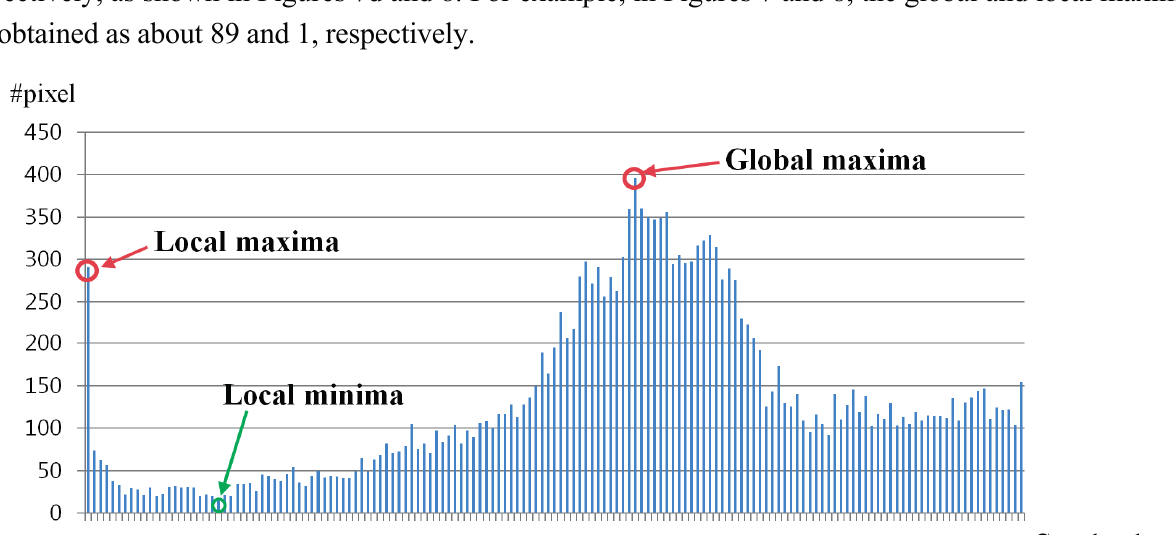
Figure 8. Detecting the position of local minima between the positions of global and local maxima. Between the positions of the global and local maxima, the position of local minima (whose number of pixels is the smallest) can be detected, which represents the boundary between the iris and pupil areas. Therefore, our system set this position of local minima as the threshold for